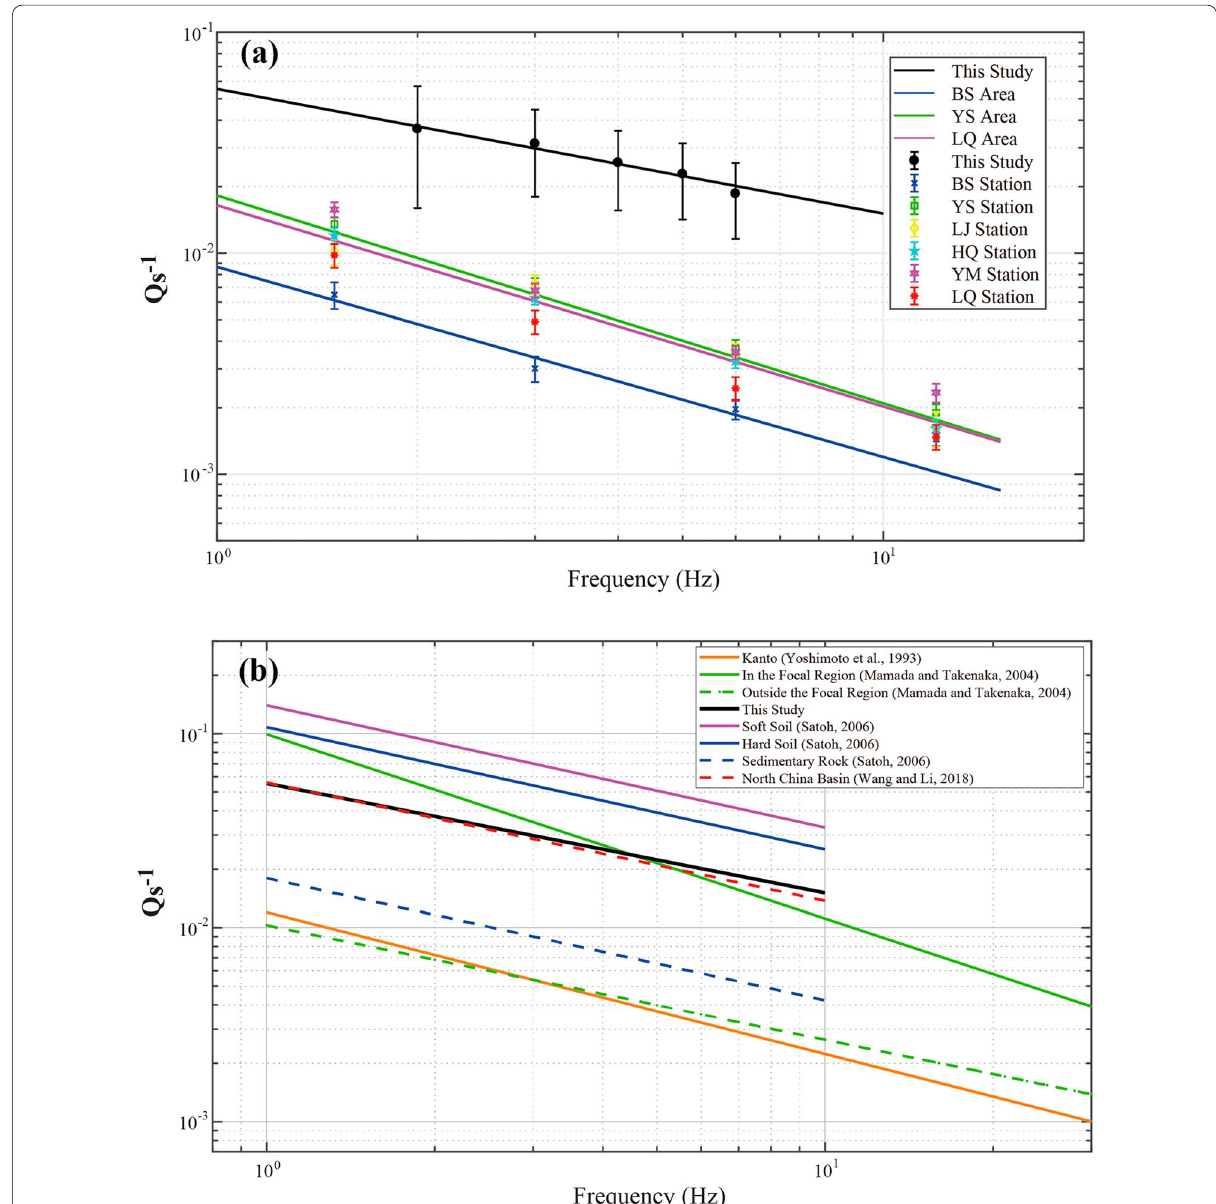
Fig. 16 Comparison with previous research results. a Is the comparison with the results of adjacent areas. The results of the present study are plotted by black solid circles. The error bar indicates the fitting deviation. The solid black line is the curve of Q − 1 s versus frequency obtained in this study. The blue crosses, green squares, yellow diamonds, bright blue pentagrams, magenta hexagrams and red stars show the Q − 1 s value of BS station, YS station, LJ station, HQ station, YM station and LQ station, respectively (Wang et al. 2005). b Is a comparison of the power law decaying model for Q − 1 s in different areas and rock types. The black solid line is the result for our study. The orange solid line, green solid line and green dash line show the result in the Kanto area (Yoshimoto et al. 1993), in the focal region and outside the focal region (Mamada and Takenaka 2004), respectively. The magenta line, blue solid line and blue dash line are the Q − 1 s model for shallow structure of soft soil, hard soil and sedimentary rock (Satoh 2006). The red dash line indicates the decaying model in the North China Basin (Wang and Li